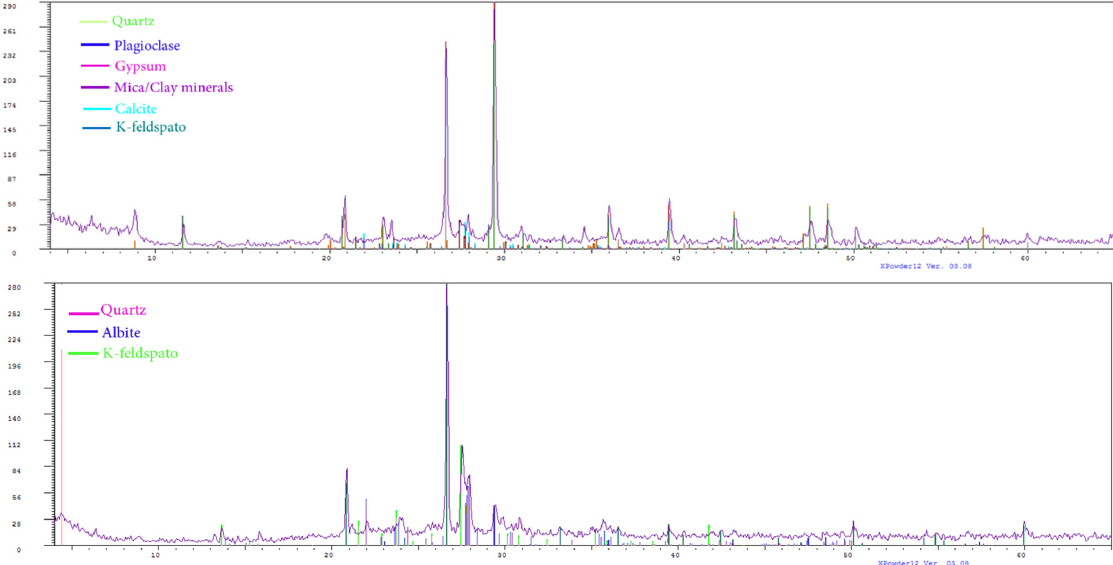
Figure 4. Mineralogical composition of representative brick samples for XRD analysis. Upper panel: sample B3 (yellow); below panel: sample B1 (red).